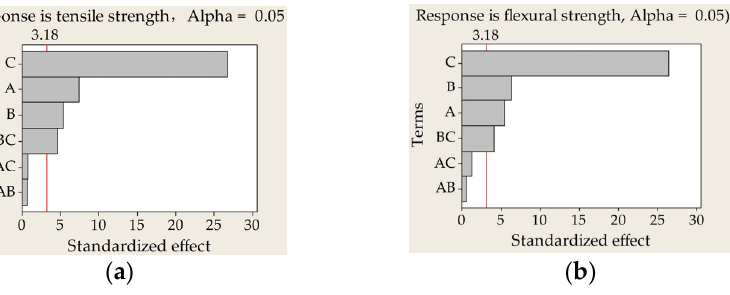
Figure 3. Pareto charts of the standardized effects on mechanical properties of laser-sintered 10%- CPLA parts: ( a ) standardized effect of tensile strength; ( b ) standardized effect of flexural strength. (A, laser powder; B, scan speed; C, scan spacing) .